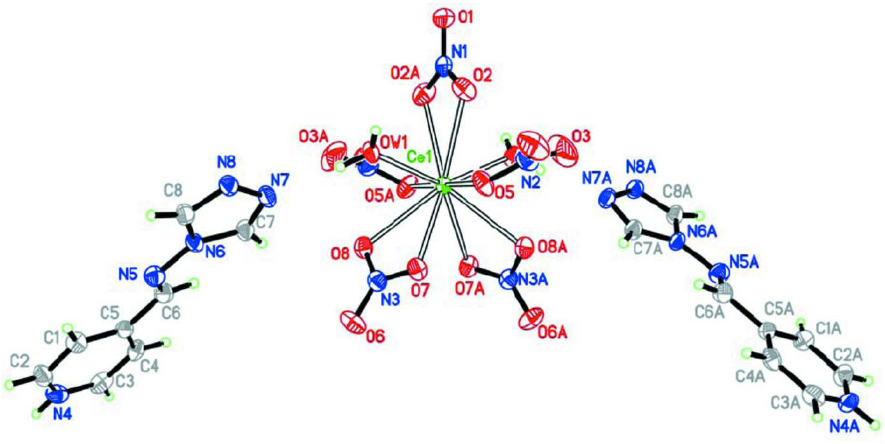
Figure 1 The molecular structure of the title molecule, with the atom-numbering scheme. Displacement ellipsoids are drawn at the